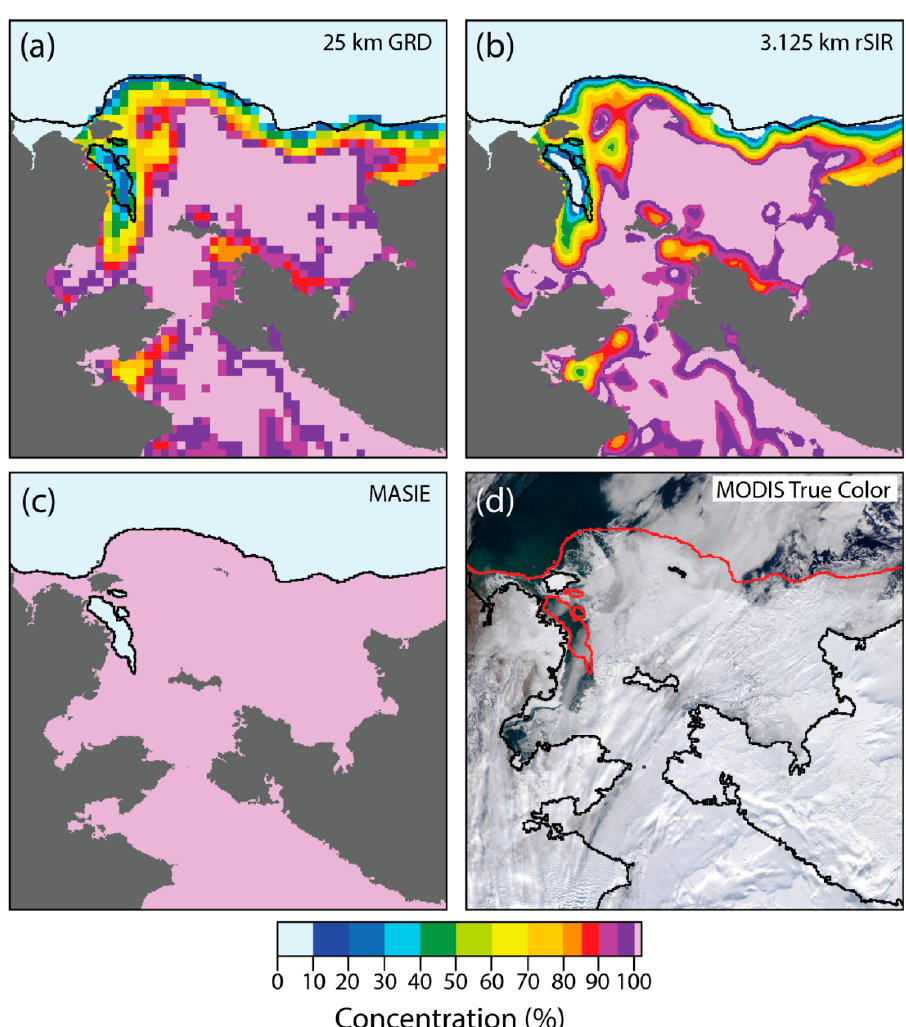
Figure 4. Bering Sea 1 March 2014 ( a ) 25 km GRD sea ice concentration, ( b ) 3.125 km rSIR concentration, ( c ) Multisensor Analyzed Sea ice Extent (MASIE) sea ice extent, ( d ) MODIS true color image. The MASIE ice edge is outlined in black (a–c) or red (d).